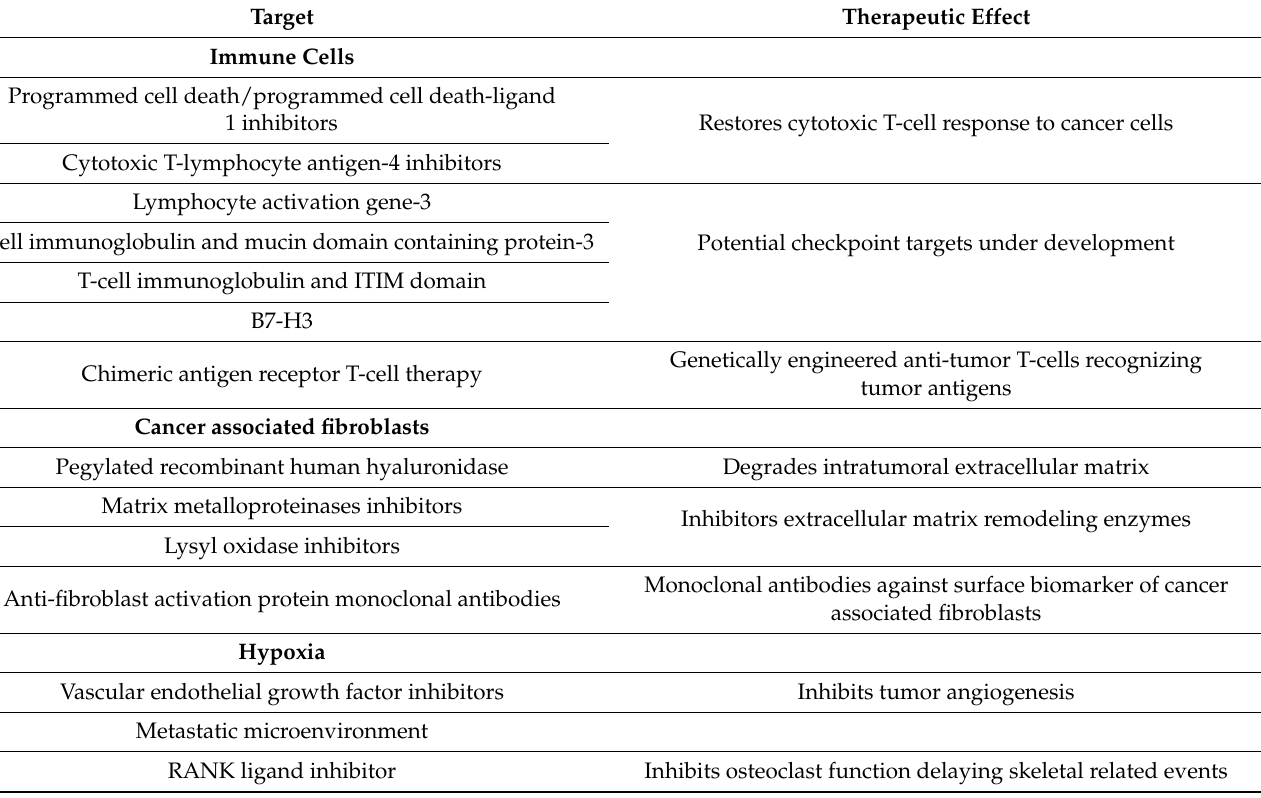
Table 2. Therapies targeting the tumor